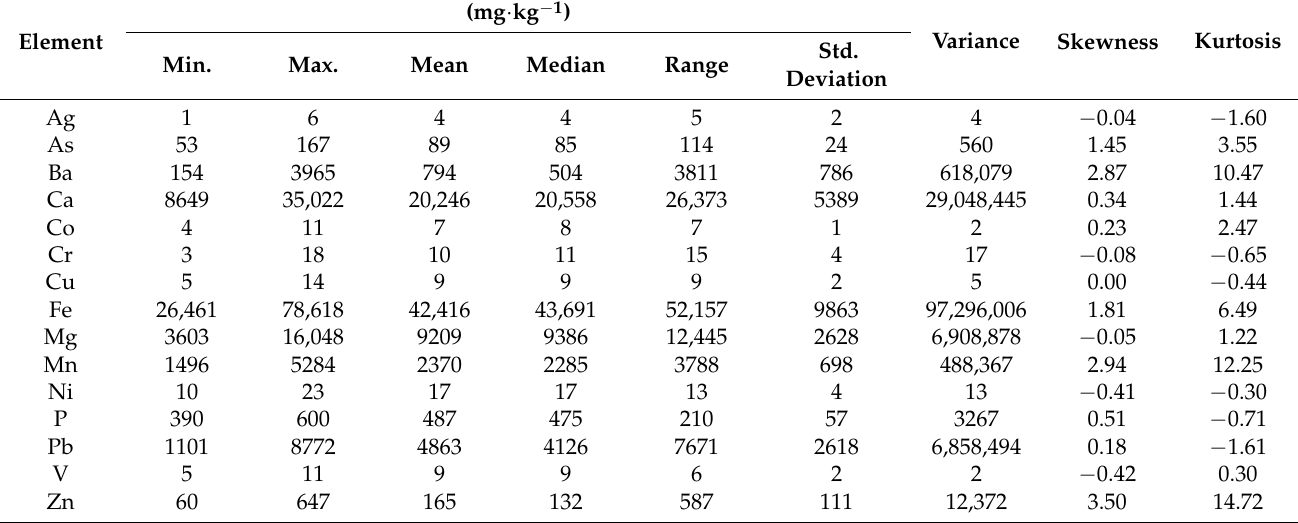
Table 3. Descriptive statistics of the total concentration of metal(oid)s. Values above the generic reference levels defined by the Andalusian government for contaminated soils are highlighted in bold. The shaded values are those that exceed the intervention values established by the Dutch